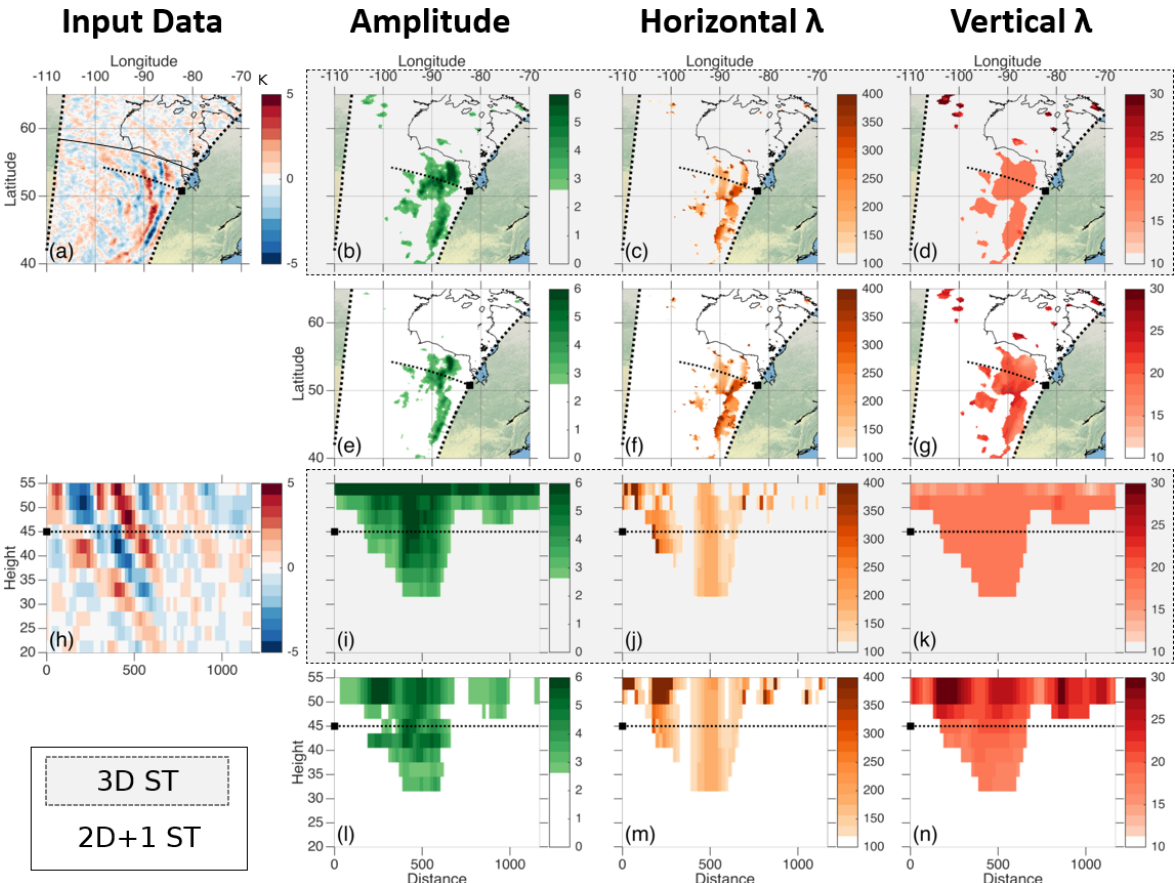
Figure 8. As in Fig. 6 but for a convective wave observed over North America in July 2008 and with horizontal cuts taken at 45km altitude. A discontinuity is visible in some panels between a region on the equatorward side of the maps and a region on the poleward side; this is due to a switch between the nighttime and daytime retrievals, which have very different noise